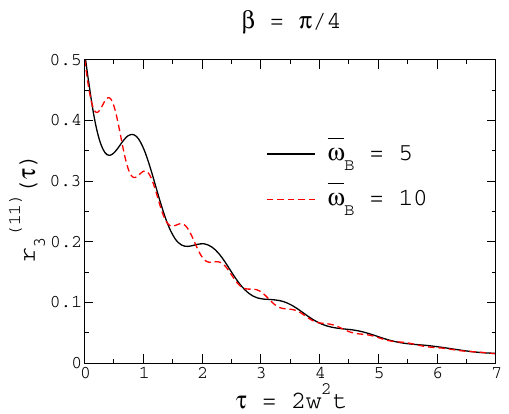
(τ) for two different values of the reduced Fig. 5 The function r ( 11 ) 3 frequency ¯ ω and a fixed value β = π/ 4. The initial conditions are ( 0 ) = 1 / 2, r ( 11 ) ( 0 ) = 0, r ( 11 ) ( 0 ) = 1 / 2, meaning that (cid:13) ( 11 ) r ( 11 ) ± 0 3 ( 11 ) = ρ ( 11 ) = ρ ( 11 ) = 0. The results are in line with the 1 and ρ 12 21 22 asymptotic behaviors of ζ 3 and Re (ζ 1 , 2 ) in Figs. 2 and 3 respectively